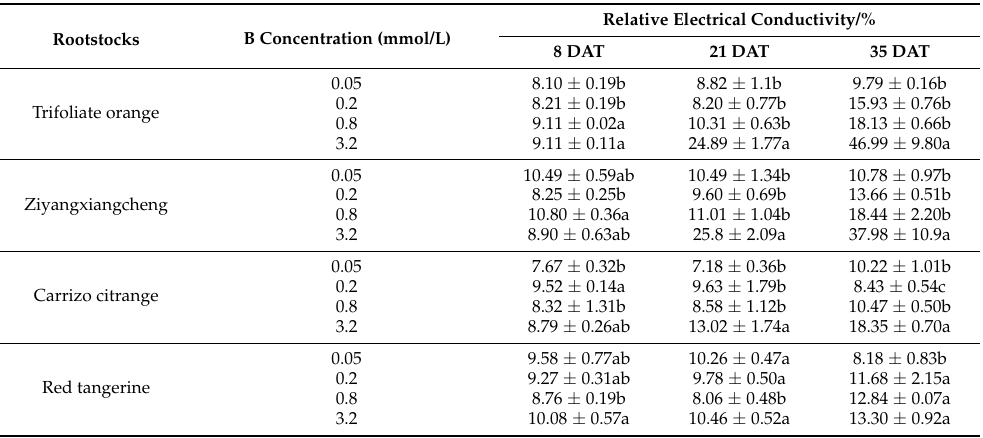
Table 5. The impact of excess B stress on relative electrical conductivity in the leaves of four citrus rootstock